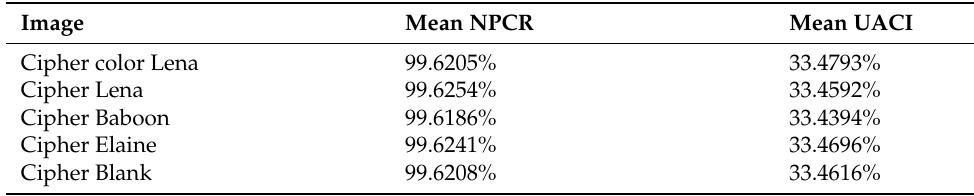
Figure 10. Plots of the NPCR and UACI measures between cipher images corresponding to plain images differing in one least significant bit. Table 7. Means of the NPCR and UACI measures.